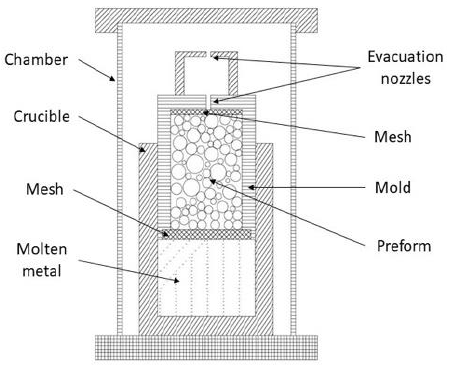
Figure 2. Schematic view of a Counter-Gravity Pressure Infiltration Mechanically Assisted Method (CGIM) equipment, adapted from [41].